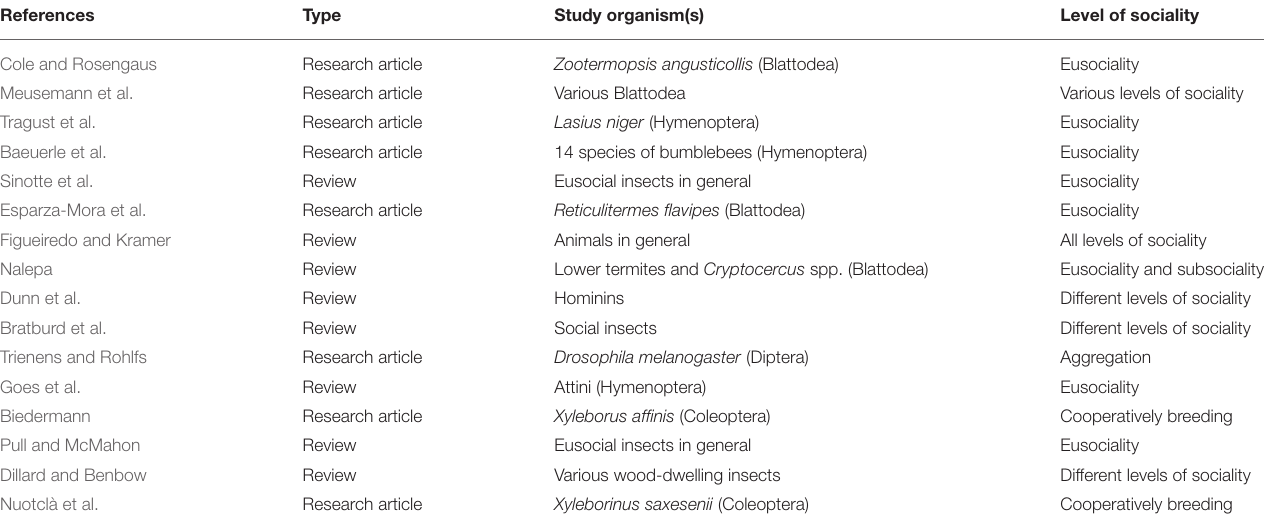
TABLE 1 | Articles included in our Research